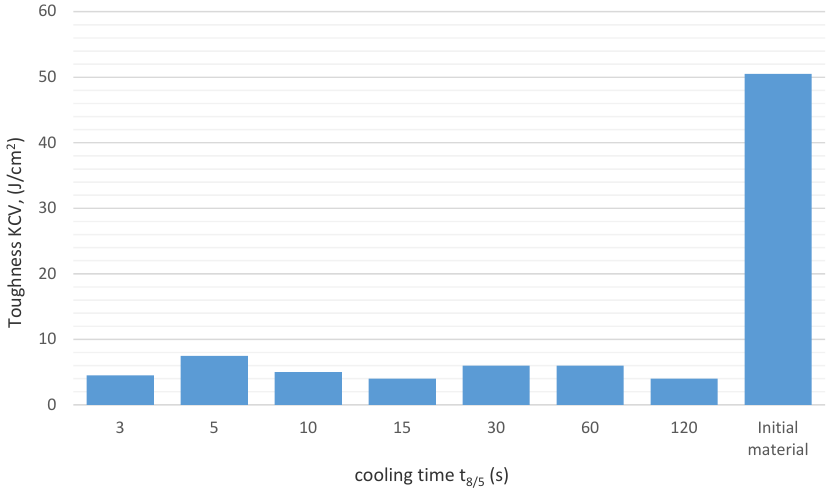
Figure 23. Toughness of S700MC steel thermo-mechanically simulated HAZ area at temperature − 30 ◦ C in dependence of cooling time t 8 / 5 , the maximum temperature of the thermal cycle was approximately 1250 ◦